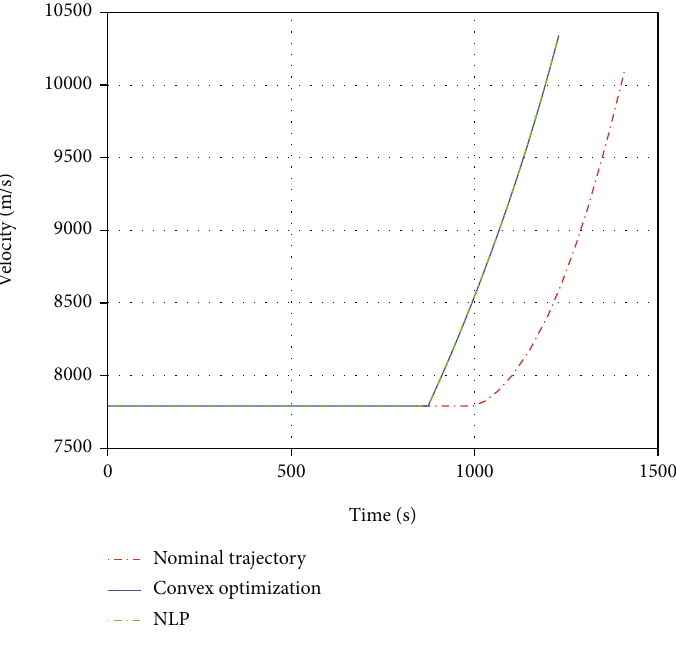
Figure 11: Curve of